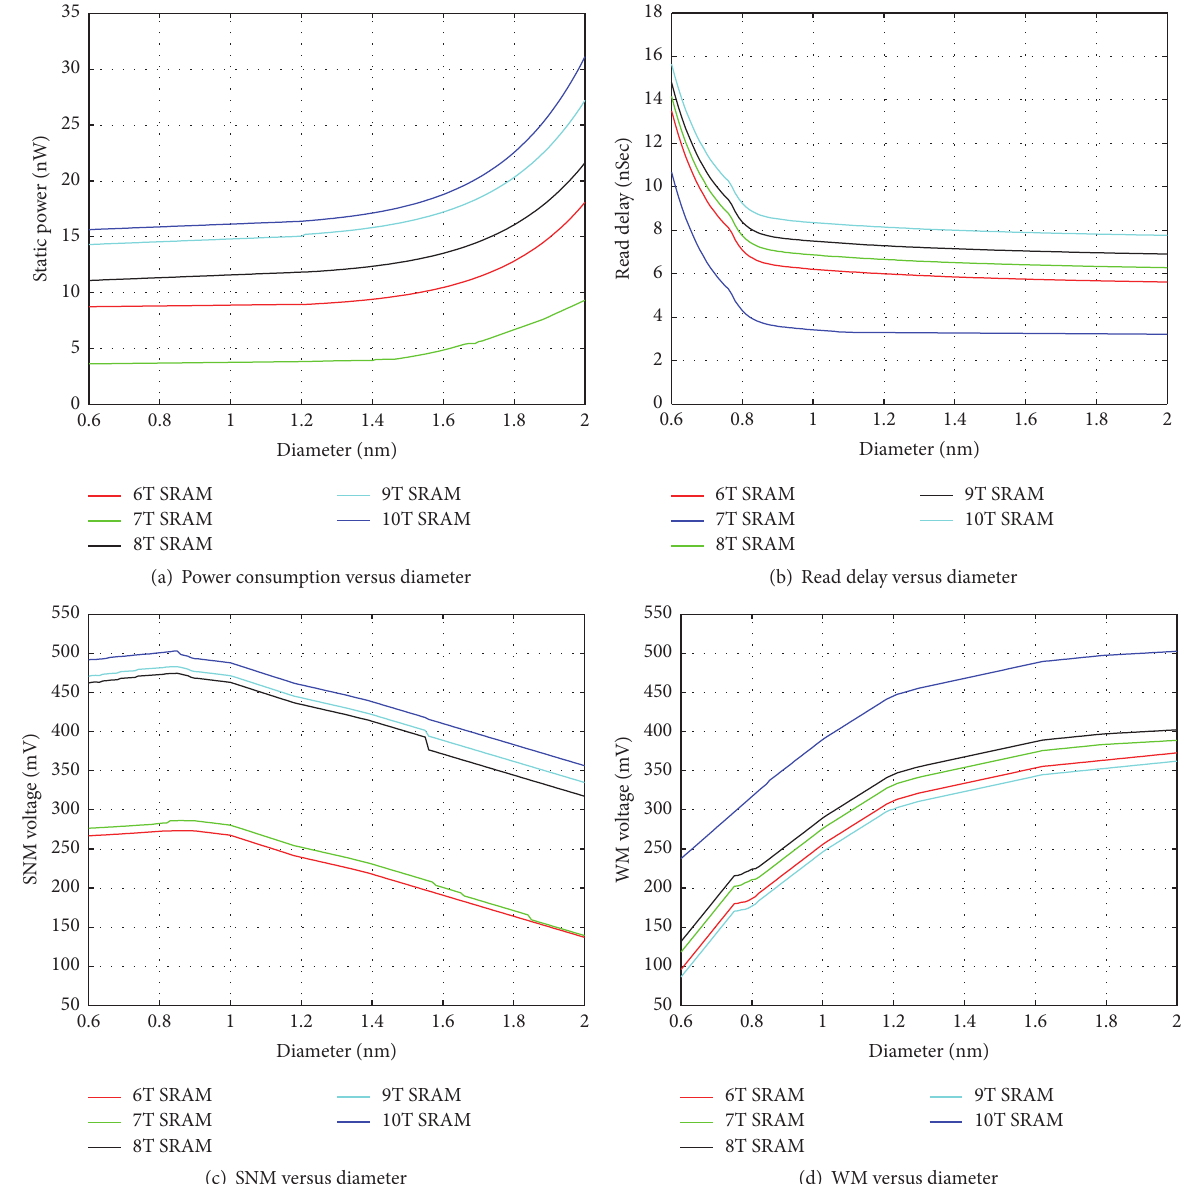
Figure 12: Dependence of SRAM characteristics on the variation in the CNT